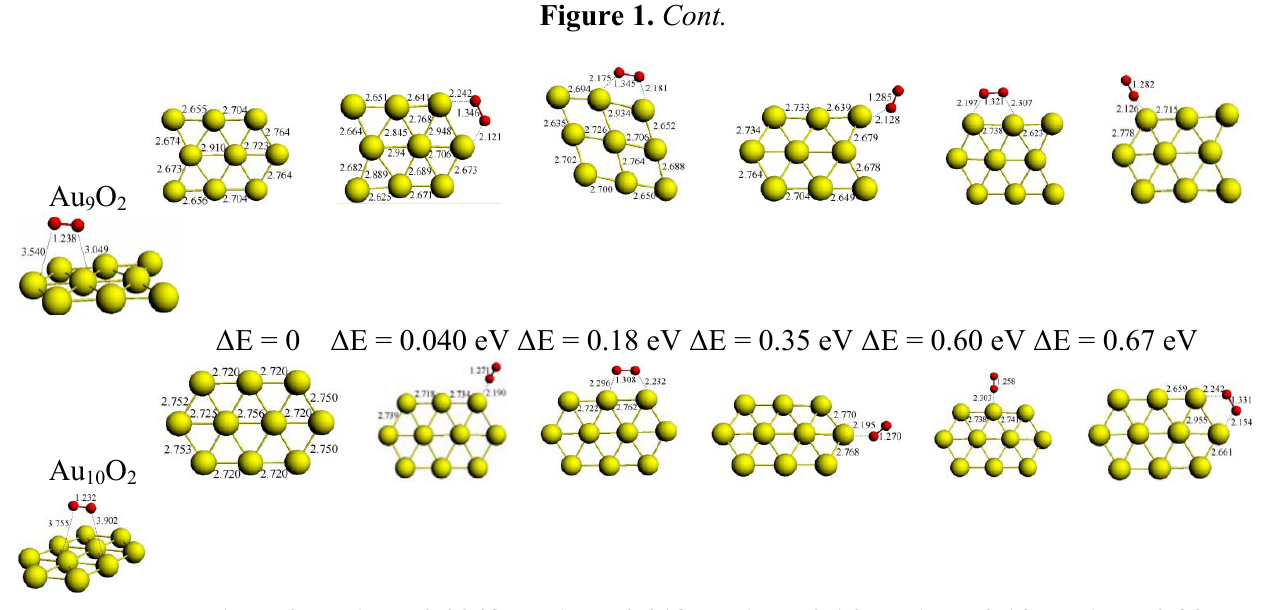
( n = 2–10) clusters. The values in the n